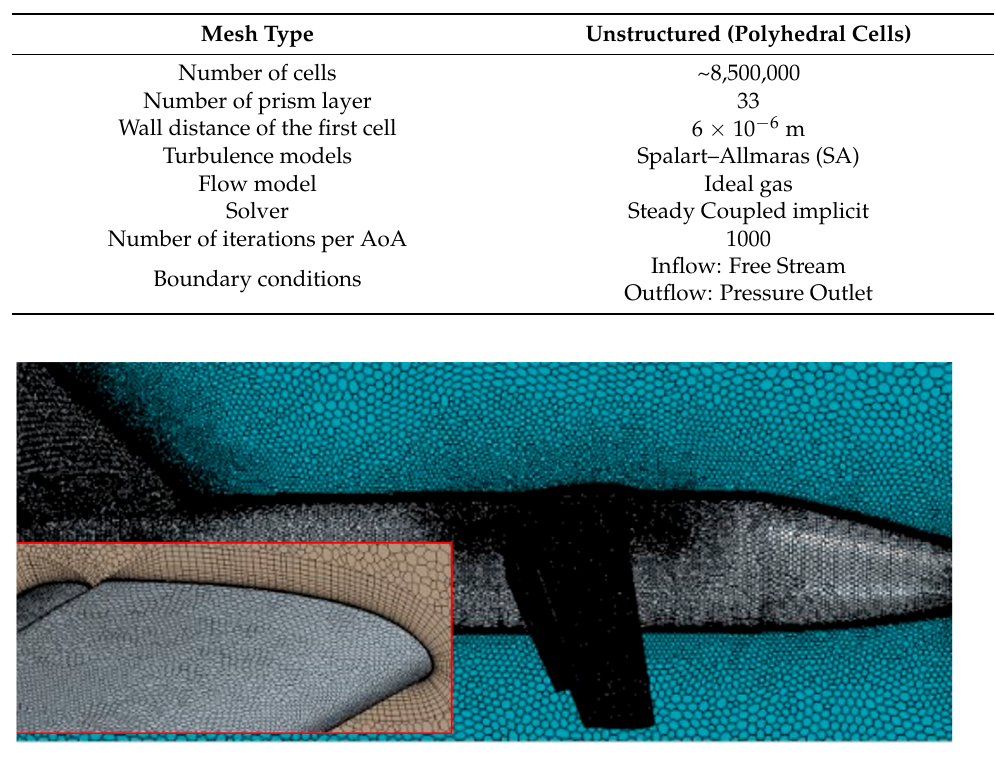
Table 2. Mesh and numerical model parameters.